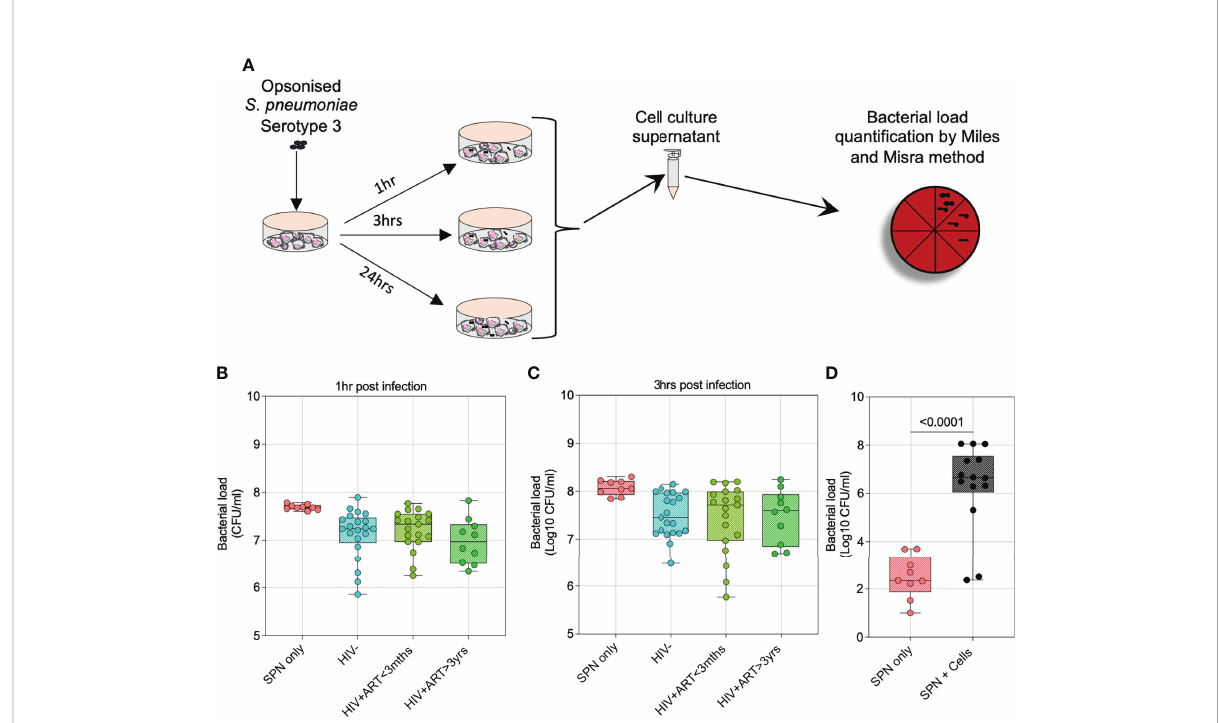
FIGURE 1 Airway cells suppress pneumococcal outgrowth better during early phases of infection. To compare the growth kinetics of S . pneumoniae Serotype 3 in the presence and absence of human airway cells, bacteria were grown in a co-culture experiment and viable counts determined at the time points indicated. Prior to incubation and co-culture experiment, bacteria were IgG-opsonized. (A) Schematic outlines the experimental design for pneumococcal growth kinetics in the presence and absence of human airway cells. (B) Airway cells suppress pneumococcal growth 1-hour post infection (p.i). (C) Airway cells suppress pneumococcal growth 3 hours p.i. (D) Differential airway cell control of S . pneumoniae 24 hours p.i, bacterial detection limit was 33 cfu/ml. In a subset of individuals with detectable bacteria, pneumococcal bacterial burden was compared in conditions grown with or without airway cells. Boxplots represent the median (centre line) and interquartile range (box), minima and maxima (whiskers). Asymptomatic HIV-uninfected (n=21); asymptomatic HIV-infected on ART<3 months (n=19); asymptomatic HIV- infected on ART>3 years (n=10); control bacteria (1 hour and 3 hours p.i, n=9; 24 hours p.i, n=25). Statistics were calculated using Kruskal-Wallis, Dunn multiple comparison test and Mann-Whitney